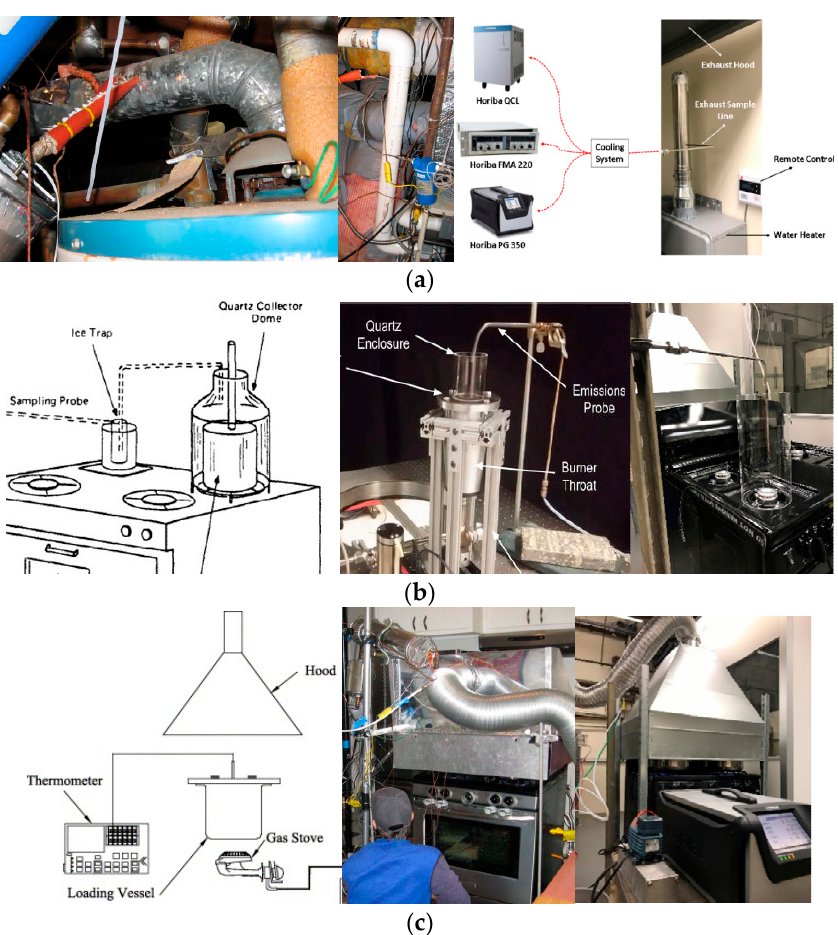
Figure 16. Emission testing methods of residential appliances. ( a ) Secured sampling [120,198]. ( b ) Quartz enclosure sampling [116,199,200]. ( c ) Exhaust hood sampling